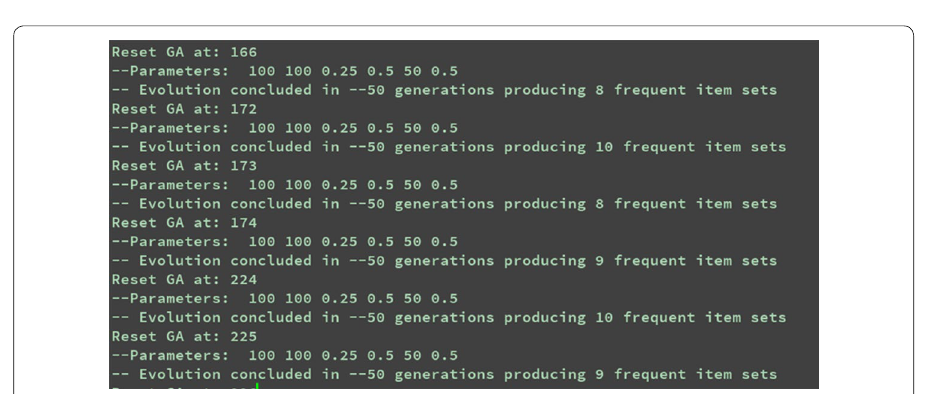
Fig. 11 Small concept drift illustration, illustration